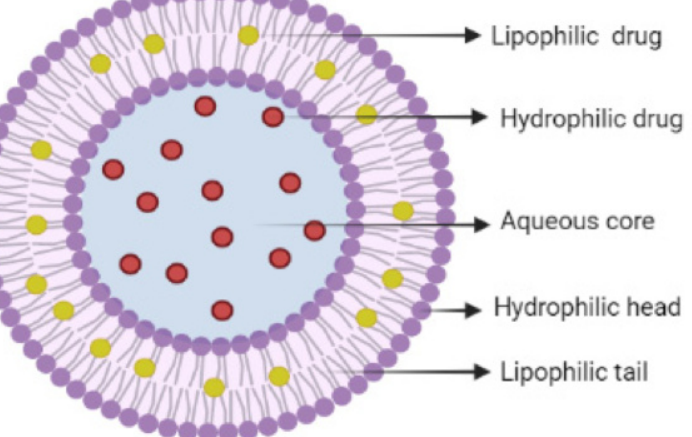
Figure 6. General structural representation of niosomes. Created with BioRender.com (accessed on 10 January